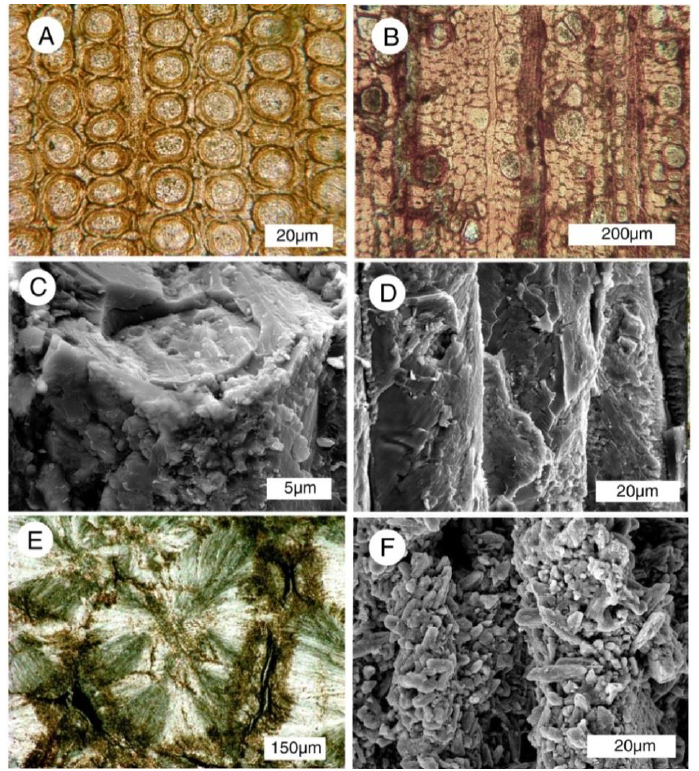
Figure 2. Calcite mineralized fossil wood. ( A – E ) are from Upper Cretaceous Nanaimo Group, Vancouver Island, British Columbia, Canada. ( A ) Specimen from Puntledge River, transverse orientation. ( B ) Specimen from Collishaw Point, Hornby Island, transverse orientation. Relict organic matter (as evidenced in acetate peels) causes thin cell walls to be brownish red; ( C ) SEM view of a single tracheid of Puntledge River wood. Cell wall appears thick because of microcrystalline calcite. Lumina are filled with more coarsely crystalline calcite; ( D ) SEM view, specimen from Port Moody, tangential orientation. Relict smooth surfaces of cell walls are mineralized with calcite; ( E ) Port Hardy specimen, transverse orientation. Polarized light illumination shows radiating calcite crystals that have disrupted cellular tissue; ( F ) Neogene wood from Glades County, Florida, USA. Tangential orientation, showing tracheid walls mineralized with coarsely-crystalline calcite.